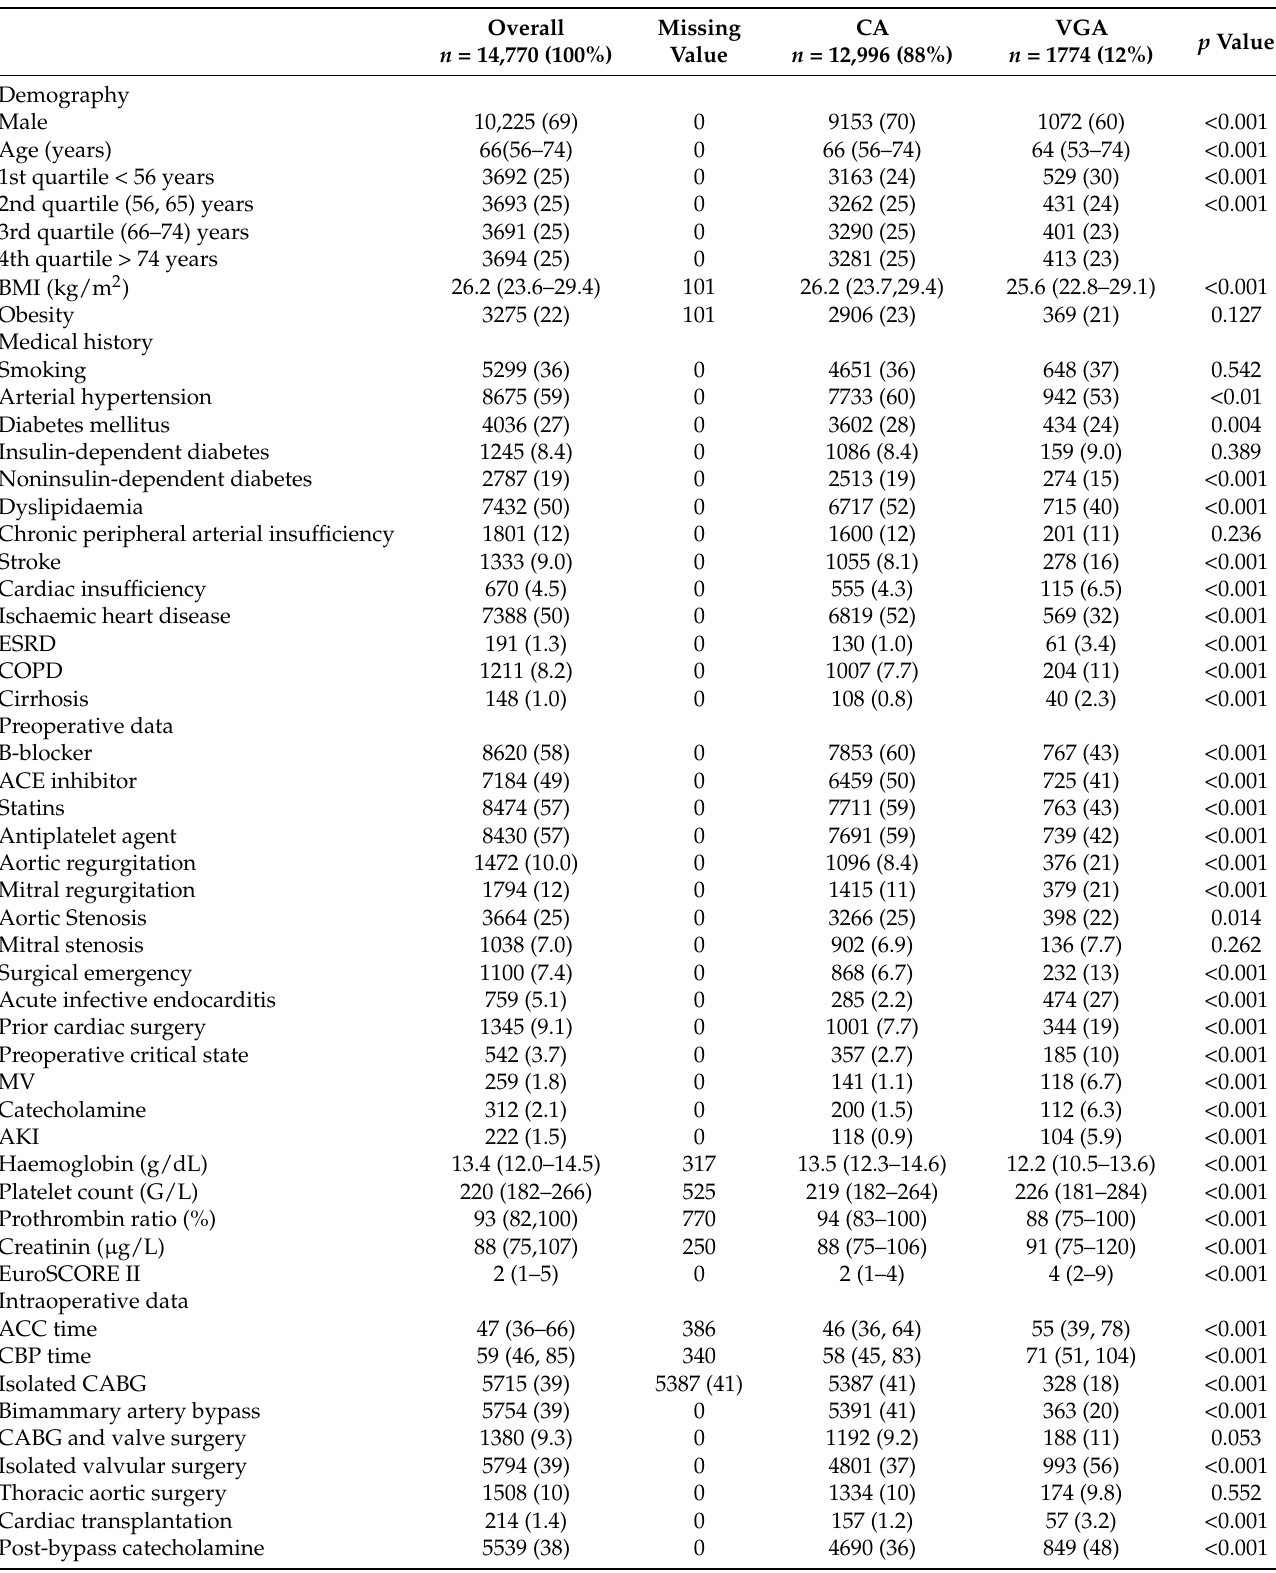
Table 1. Perioperative characteristics of patients according to the type of